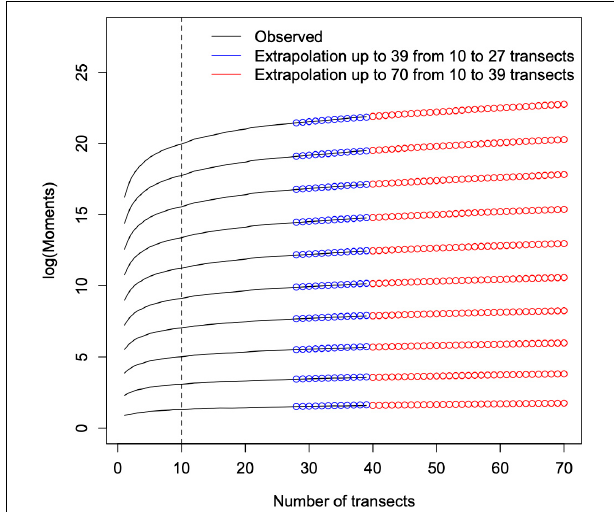
FIGURE 4 | The raw moments up to order 10 as a function of the number of transects. The full lines are the values calculated from the data, the blue circles are the values obtained by extrapolating the observed values from 10 to 27 transects and are, then, used to assess the method of extrapolation, and, finally, the red circles are the values obtained by extrapolating the observed values from 10 to 39 transects. The dashed vertical line corresponds to the threshold above which data are used to extrapolate the abundance